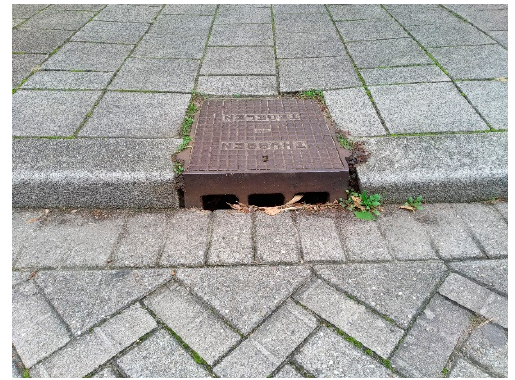
Figure 1. Roadside gully pot.